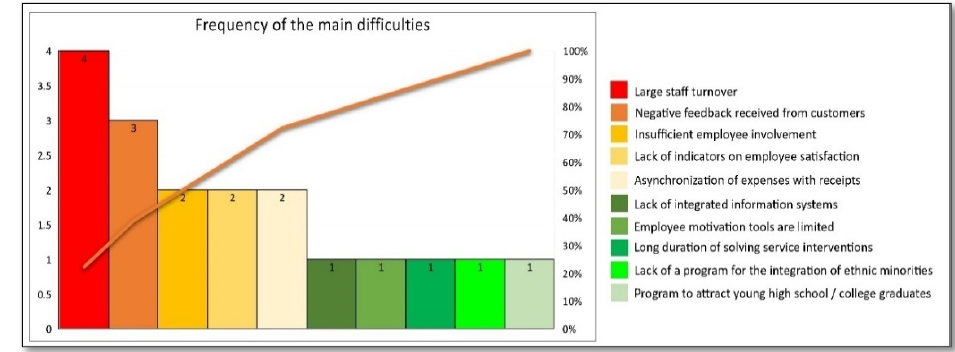
Figure 8. Frequency of occurrence by categories of difficulty.